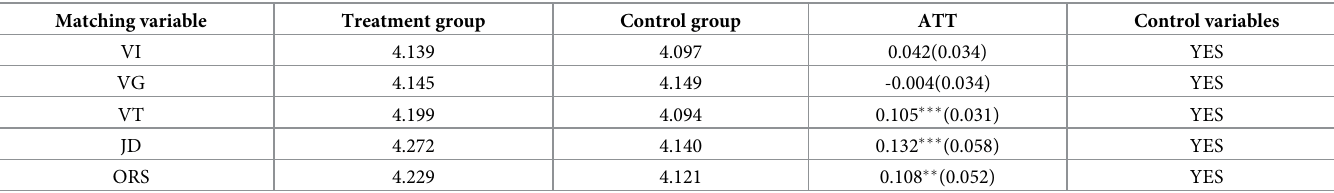
Table 8. Results of the PSM analysis (different types of public employment services).